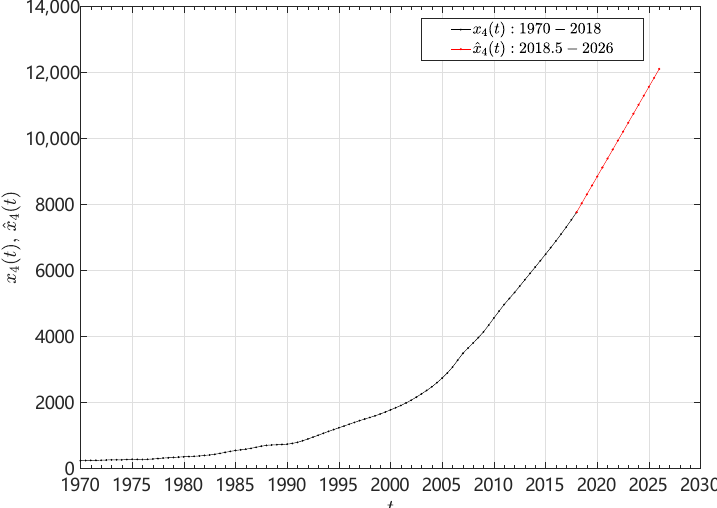
Figure 10. The GDP per capita of China versus time: Real data for 1970–2018 and estimated values for